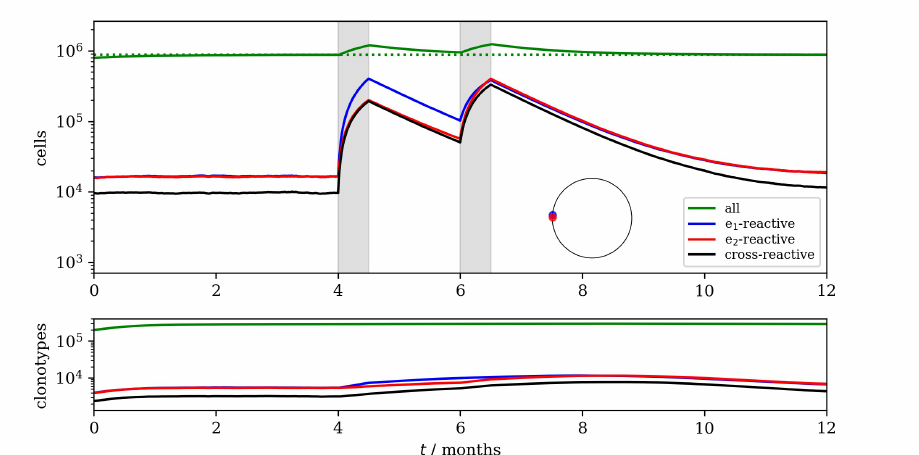
Figure 15. Two infection episodes: similar viral epitopes. The blue and red dots on the circle indicate the locations of e 1 and e 2 , respectively. The two shaded intervals indicate infection with epitope e 1 and e 2 , respectively. Top: The total number of cells is shown in green. The blue, red and black lines show the numbers of cells recognizing e 1 ; e 2 ; and both e 1 and e 2 . Bottom: The total number of surviving clonotypes as a function of time is shown in green. The blue, red and black lines show the numbers of surviving clonotypes recognizing e 1 ; e 2 ; and both e 1 and e 2 . Parameter values were: µ =